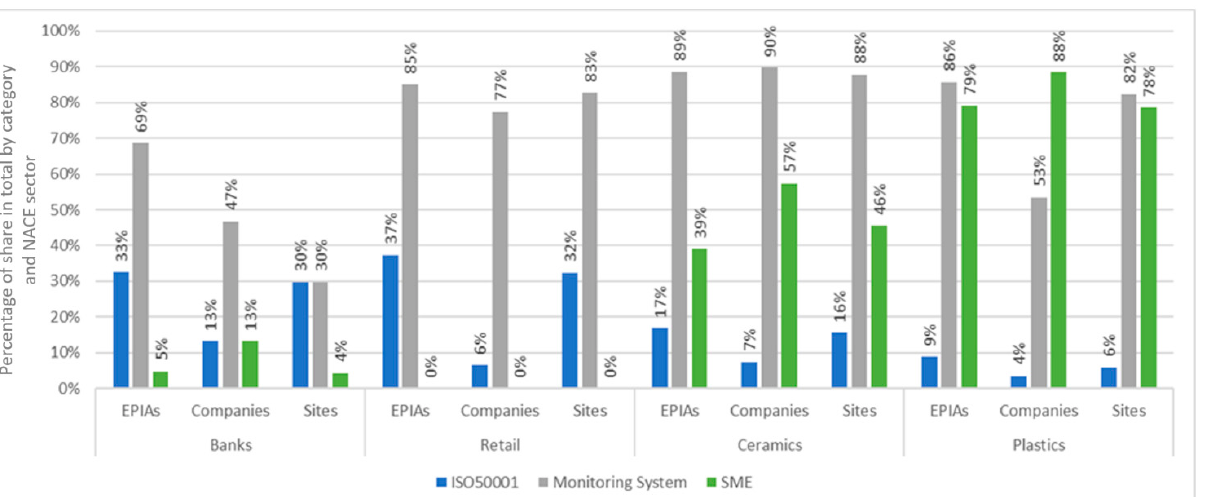
Figure 2. Share of the total final energy consumption by category.